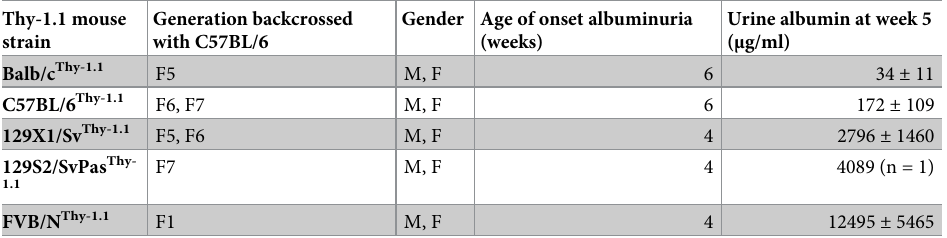
Table 2. Development of spontaneous proteinuria in Thy-1.1 mice with different backgrounds. Thy-1.1 mouse